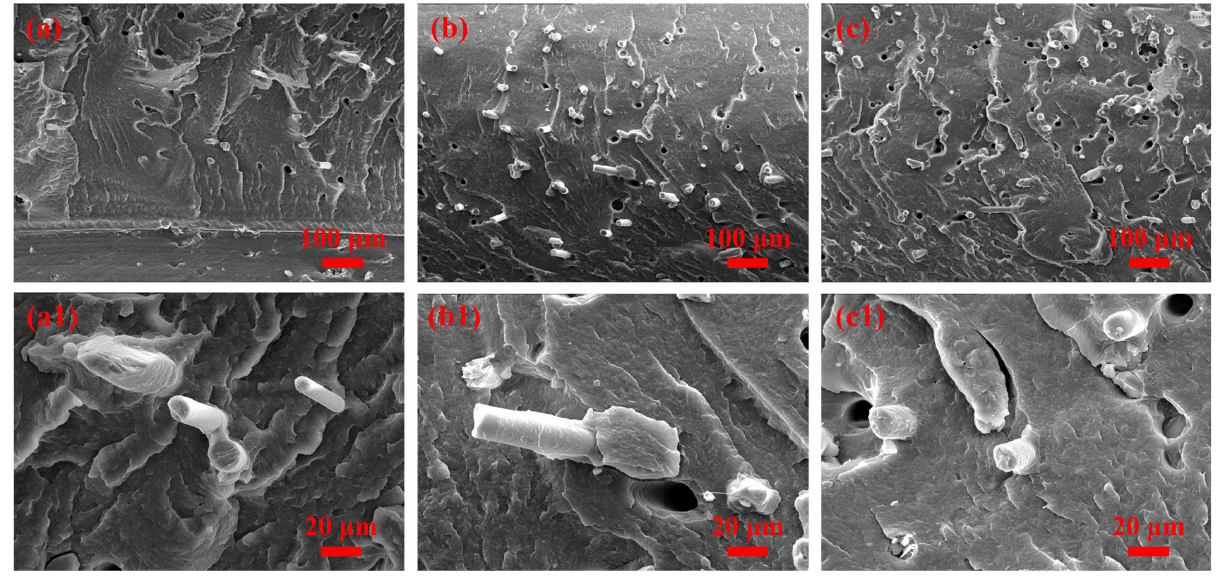
Figure 3. SEM micrographs of cryo-fractured surfaces of PA 6/SEBS/BF composites with BF contents of ( a ) 5, ( b ) 10, and ( c ) 20 wt.%; ( a1 ), ( b1 ), and ( c1 ) are magnified SEM micrographs from ( a ), ( b ), and ( c ), respectively.